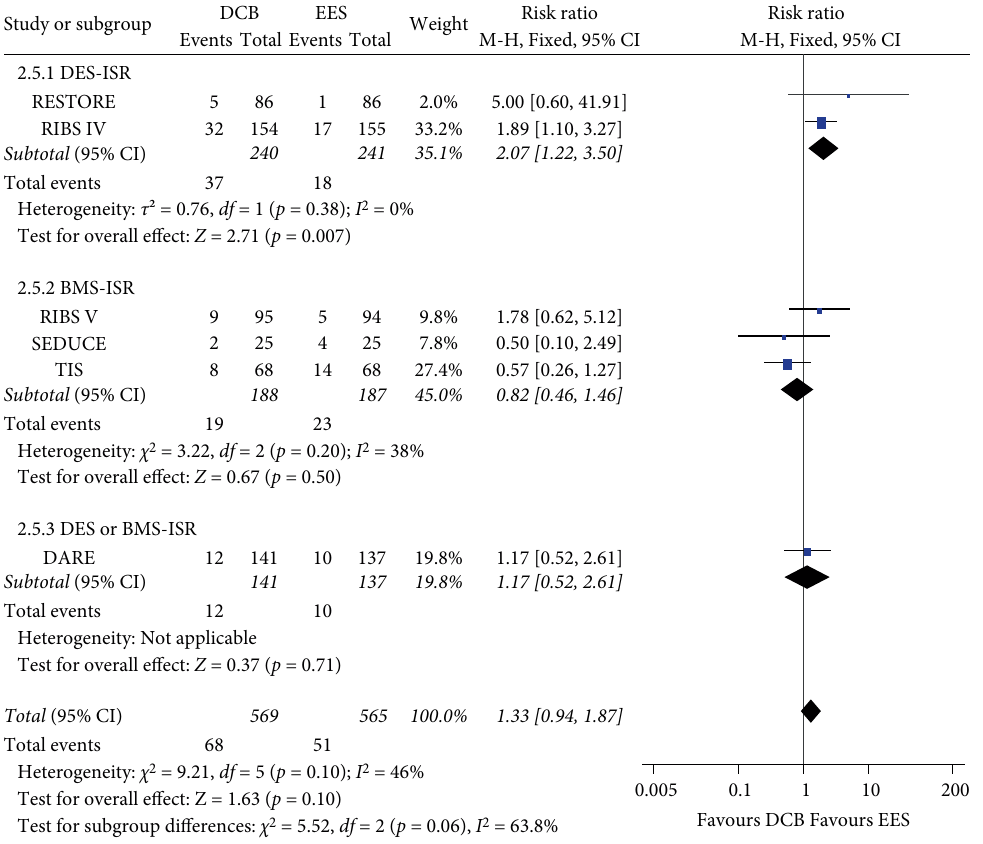
Figure 5: Comparison of the risk of TVR between DCB and EES. Subgroup analysis was performed based on the type of restenosed stent. BMS, bare-metal stents; DES, drug-eluting stents; DCB, drug-coated balloons; EES, everolimus-eluting stents; TVR, target vessel